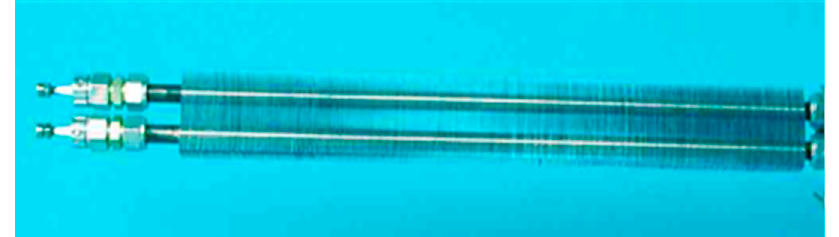
Figure 7. Modular finned tube carbon-ammonia adsorber [34].